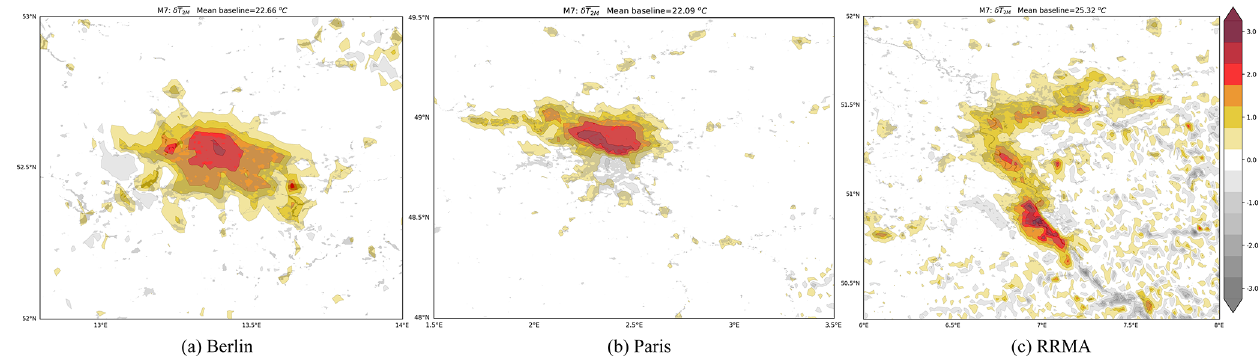
in which the respective urban agglomerate is embedded as a single